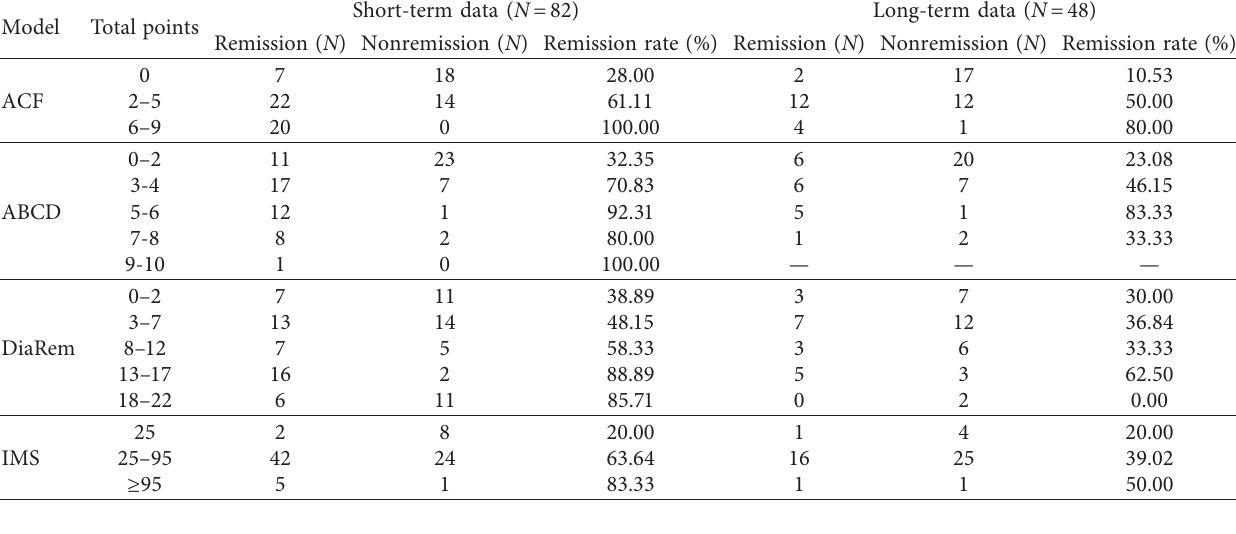
Table 8: Predictive ability of scores.